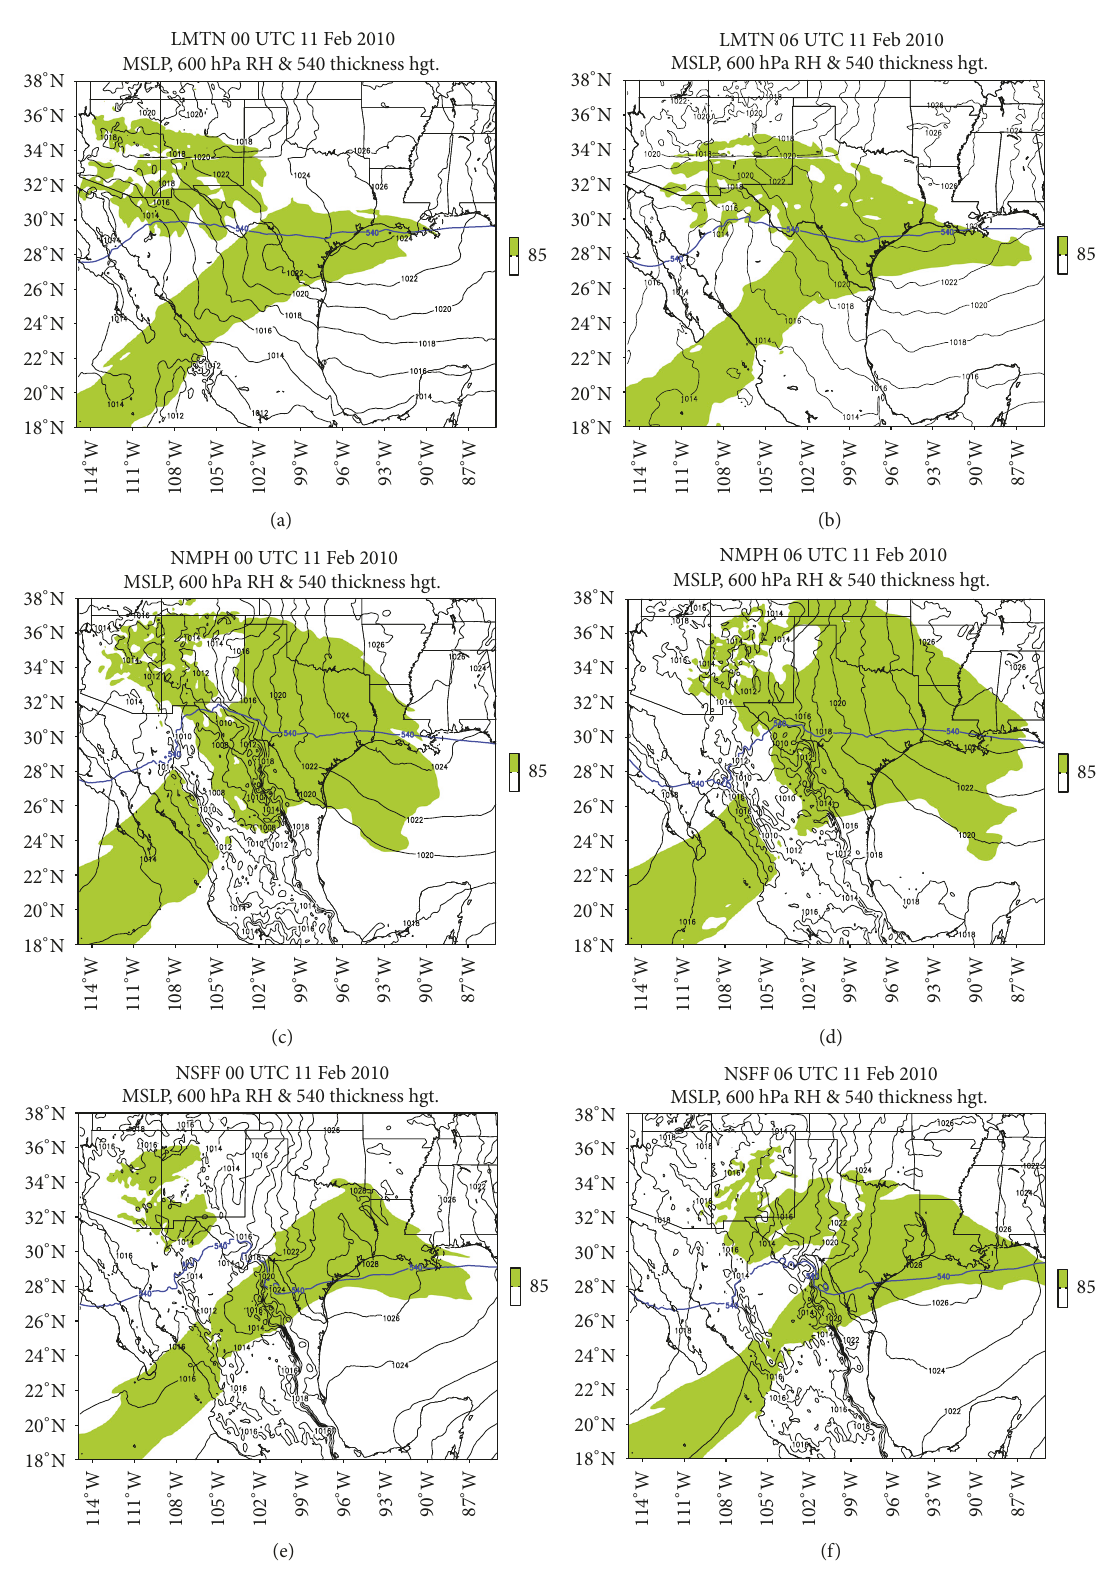
Figure 17: Simulated (12km) mean sea level pressure (in hPa), 600 hPa relative humidity, and 540 dam contour of the 1000–500 hPa thickness (in blue) on 0000 and 0600 UTC 11 February 2010 for (a-b) terrain reduction experiment, (c-d) no microphysics heating experiment, and (e-f) no surface flux